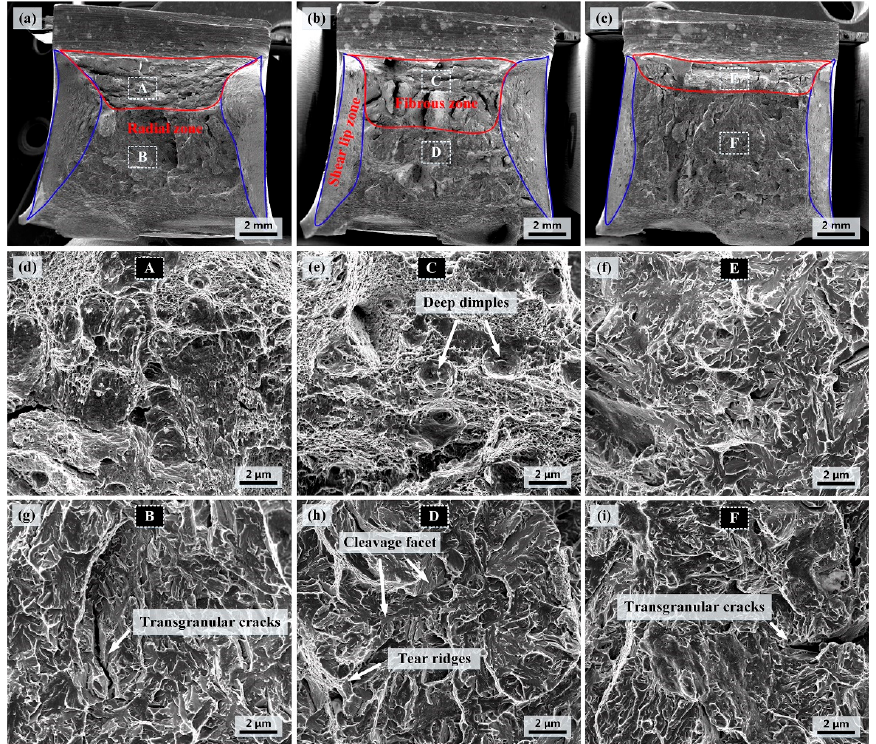
Figure 8. Micrographs of the impact fracture tested at − 60 ◦ C. ( a ) sub-surface, ( b ) t / 4, ( c ) t / 2, ( d , g )